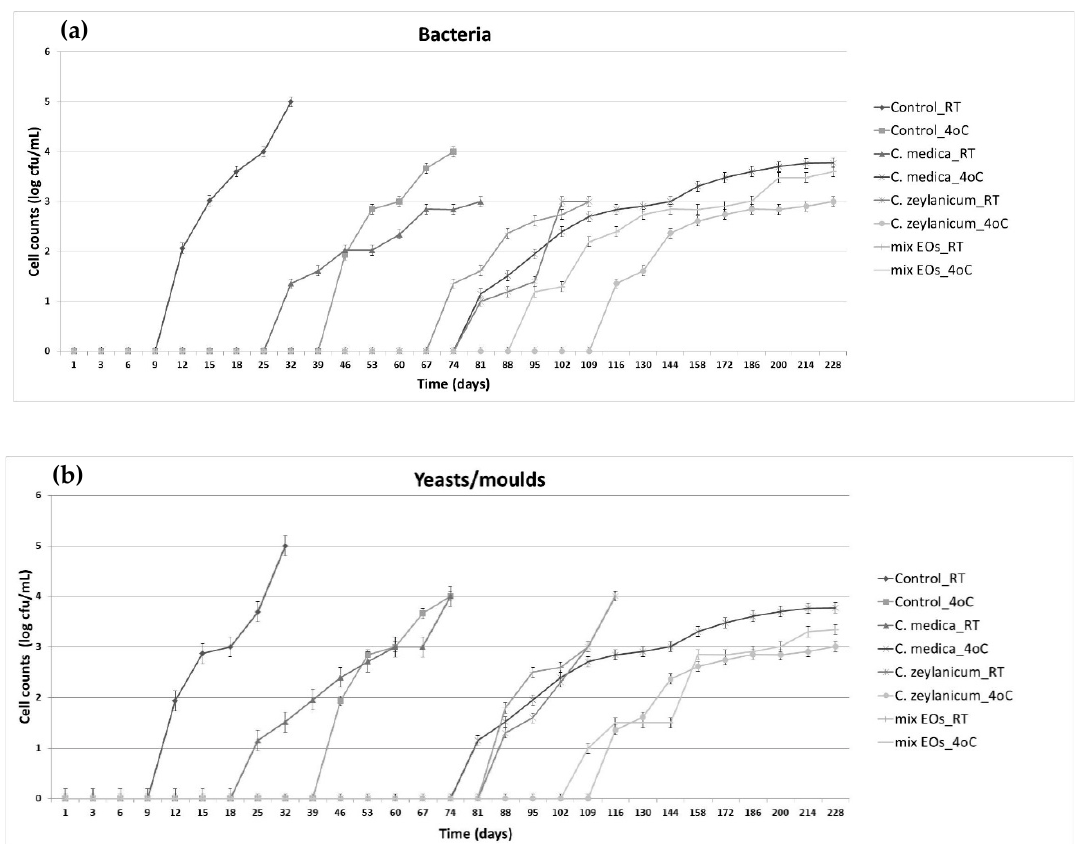
Figure 1. Effect of Citrus medica and Cinnamomum zeylanicum EOs on spoilage of low alcohol wines (~6 % vol) during storage at room temperature (18–20 °C) or at 4 °C. Wines were supplemented with either C. medica or C. zeylanicum EO (0.010%) or their mixture (0.005% of each oil). Wine with no EOs was used as control. ( a ) Bacteria counts, ( b ) Counts of yeasts/molds . Counts below the detection limit (<10 cells/mL) are indicated with 0 value.